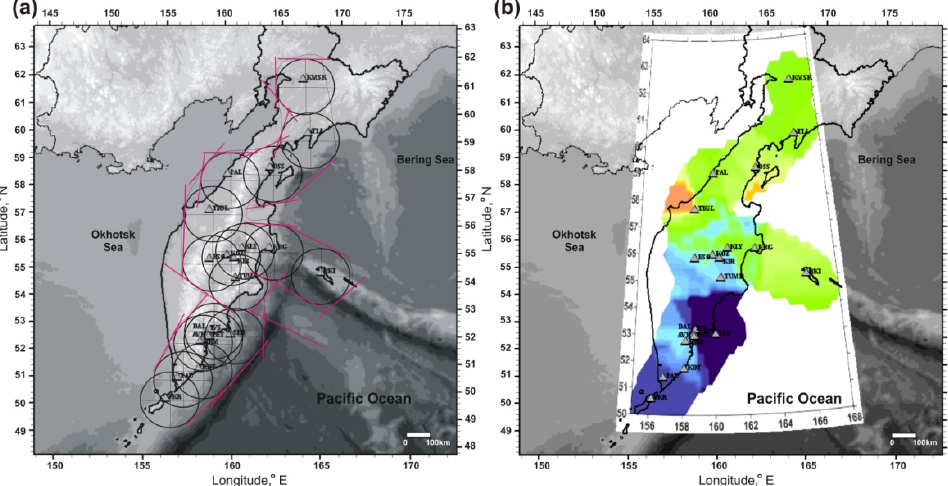
Figure 3. Determination of the coloring area on maps showing the distribution of noise parameters. ( a ) circular areas with a radius of 120 km around seismic stations; ( b ) corresponding colored area (see text for explanation).